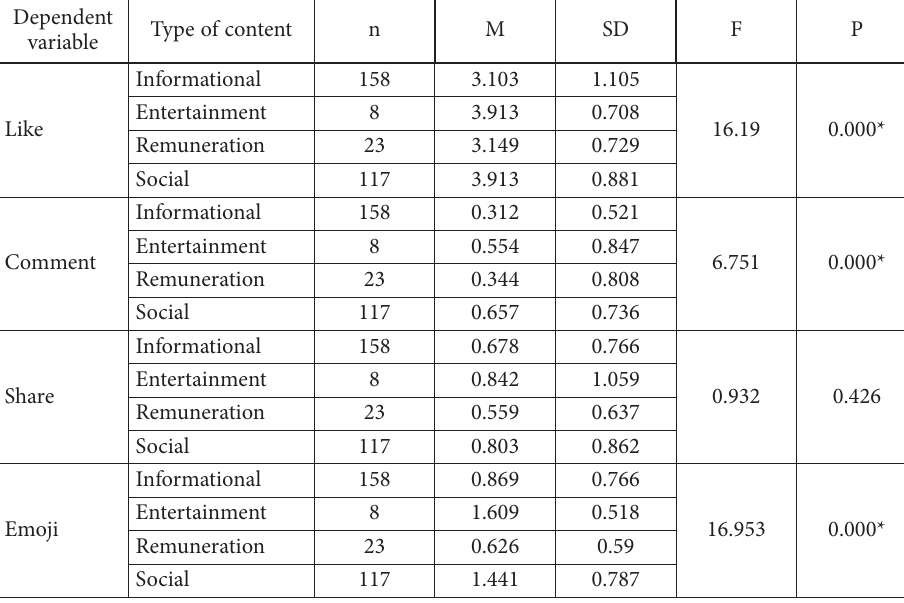
Table 1. ANOVA analysis for the effect of content type Dependent